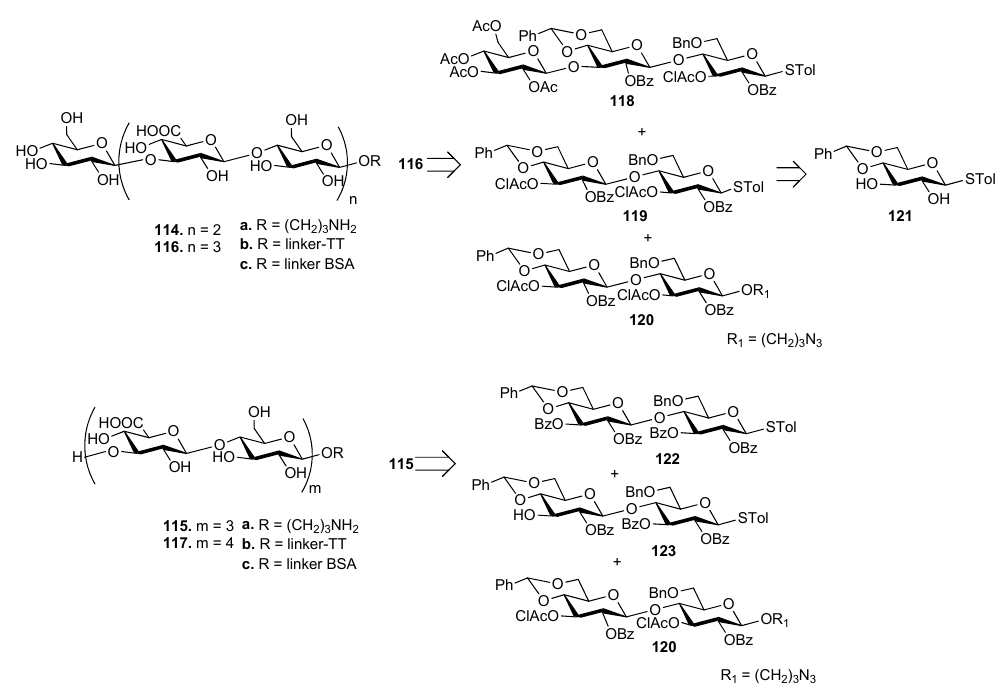
Figure 13. Synthesis of ST3 oligosaccharides and glycoconjugates from [82].